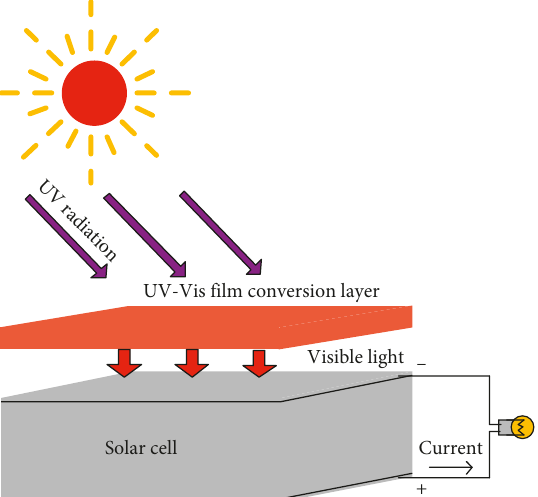
Figure 1: Schematic diagram of UV-visible conversion layer for enhanced solar